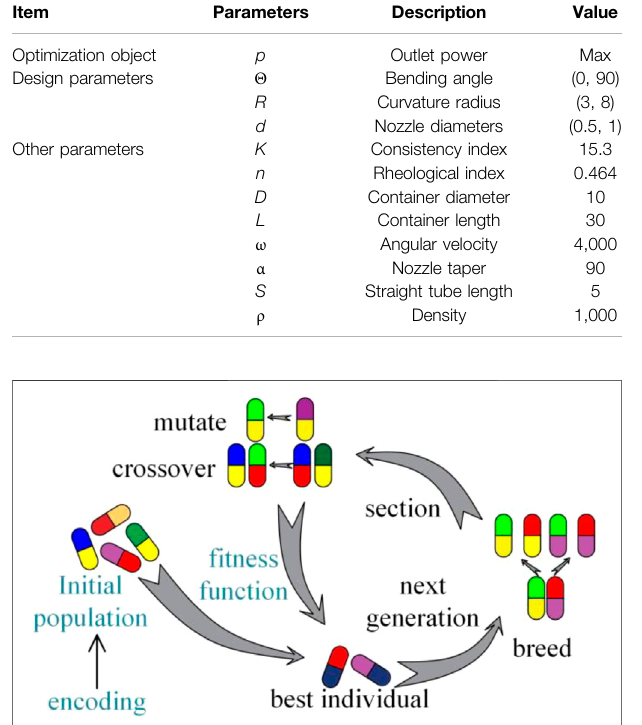
FIGURE 6 | The process of genetic algorithm.